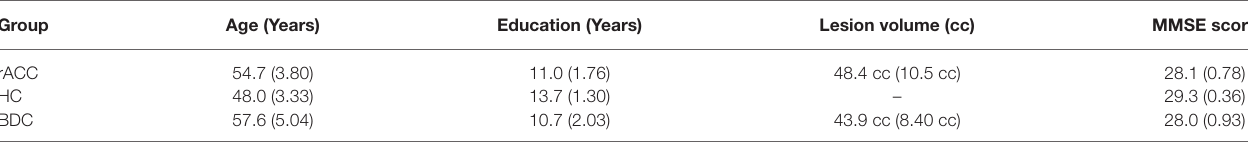
TABLE 1 | Demographic, clinical and lesion data of patients with lesions of the rostral anterior cingulate cortex (rACC Group), of brain damaged control patients (BDC Group), and demographic and clinical data of healthy controls (HC Group) .